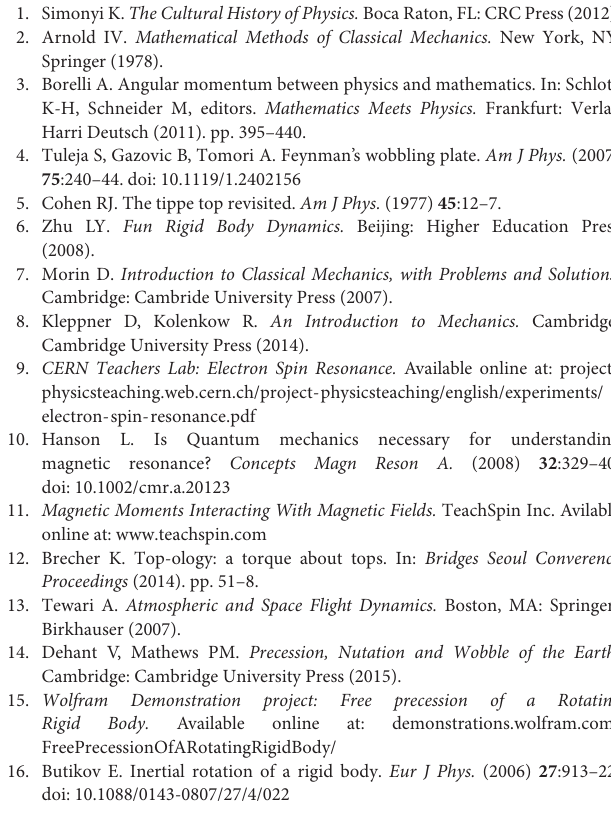
Spinning Top. Available online at: demonstrations.wolfram.com/ StationaryPrecessionOfASpinningTopRevised/